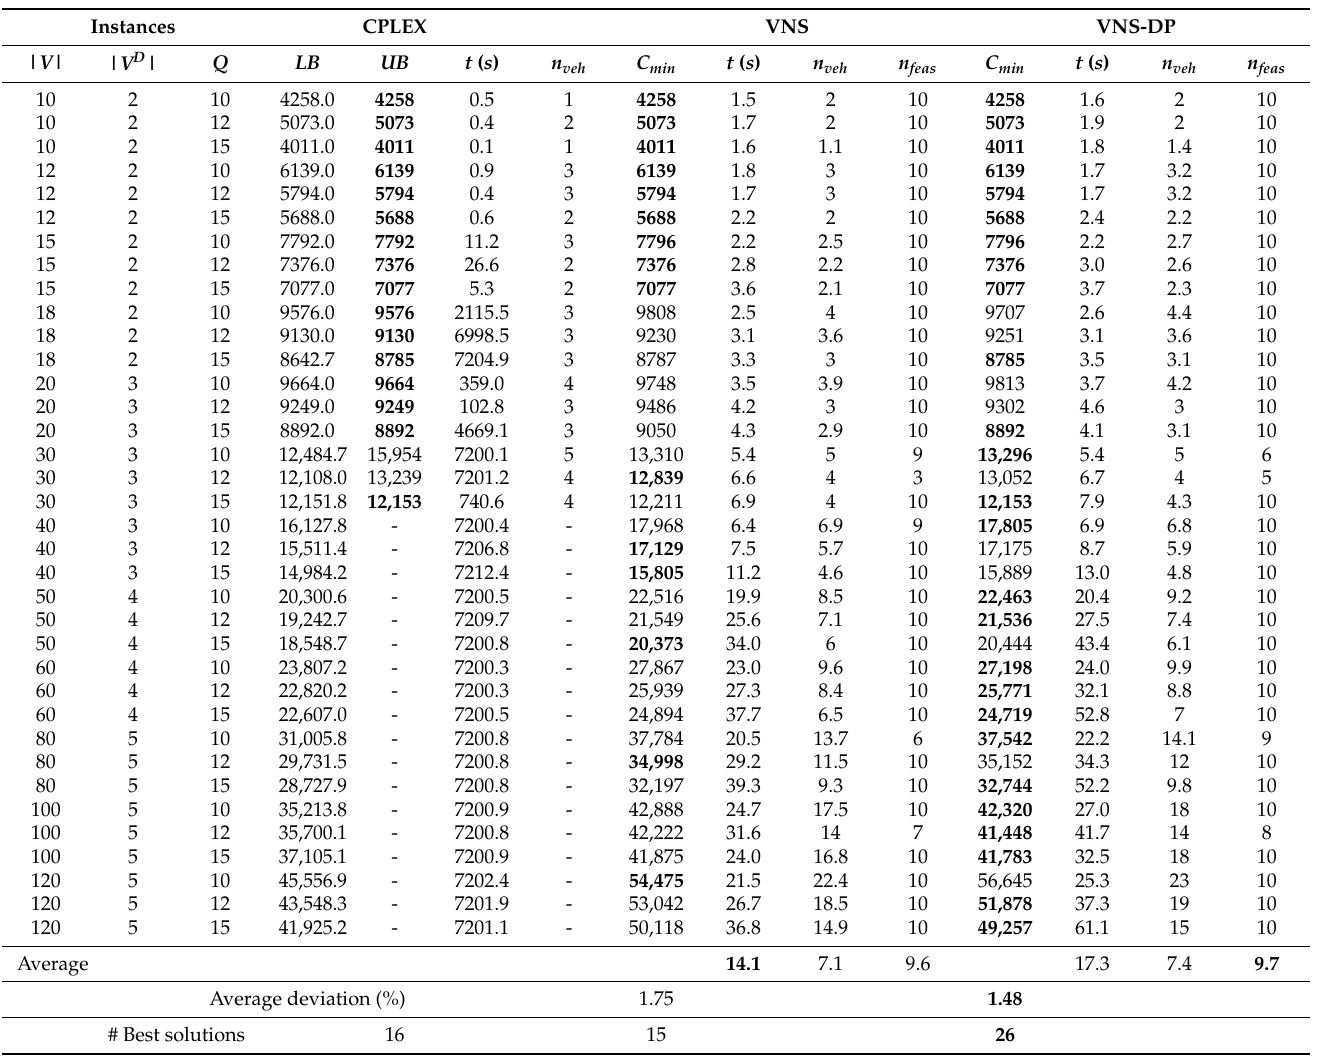
Table 7. Results for VNS-DP and VNS for random